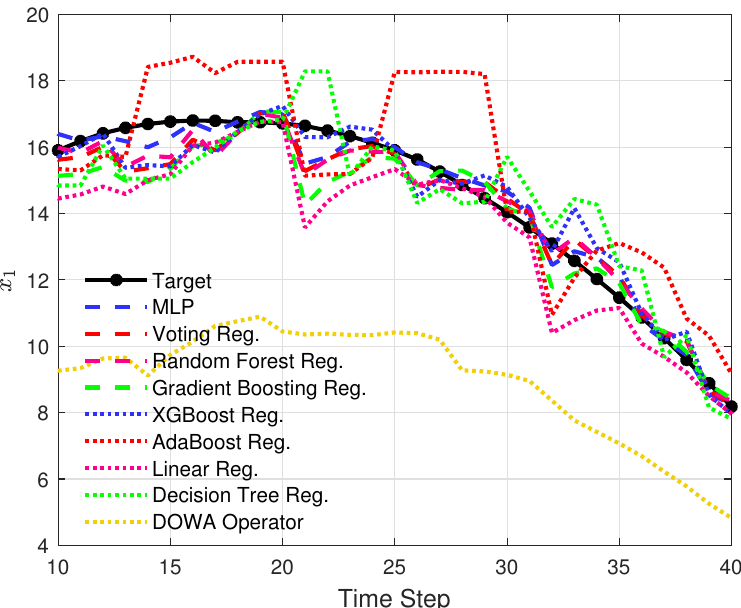
Figure 11. Fusion results for one Monte Carlo simulation for state 1 (zoomed